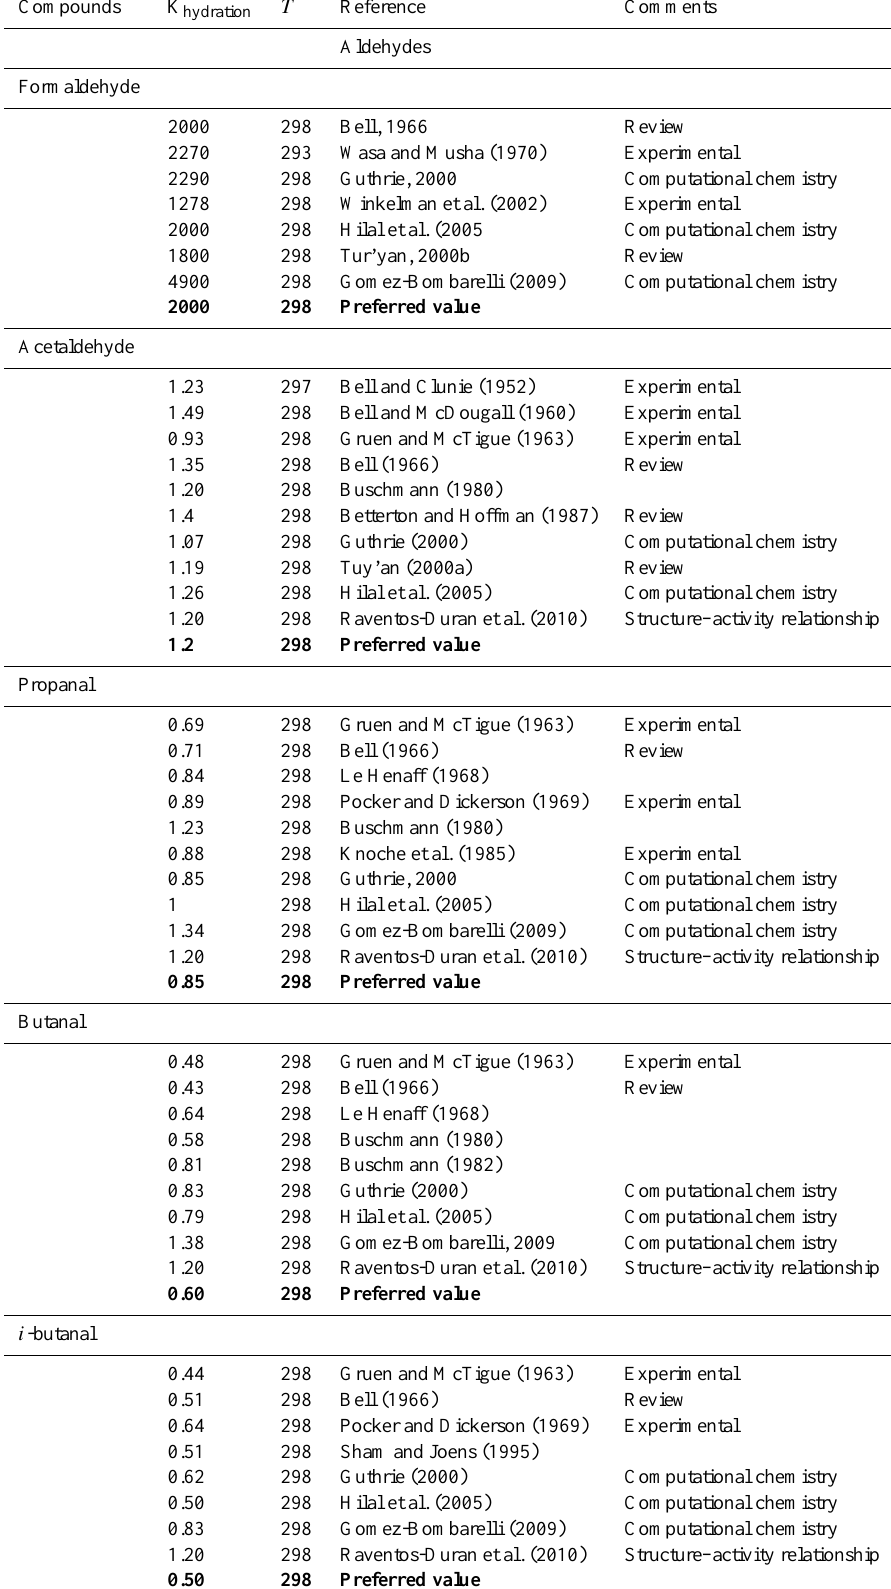
Table 1. Hydration equilibrium constants for the compounds used to define the SAR descriptors. Compounds K hydration T Reference Comments Aldehydes Formaldehyde